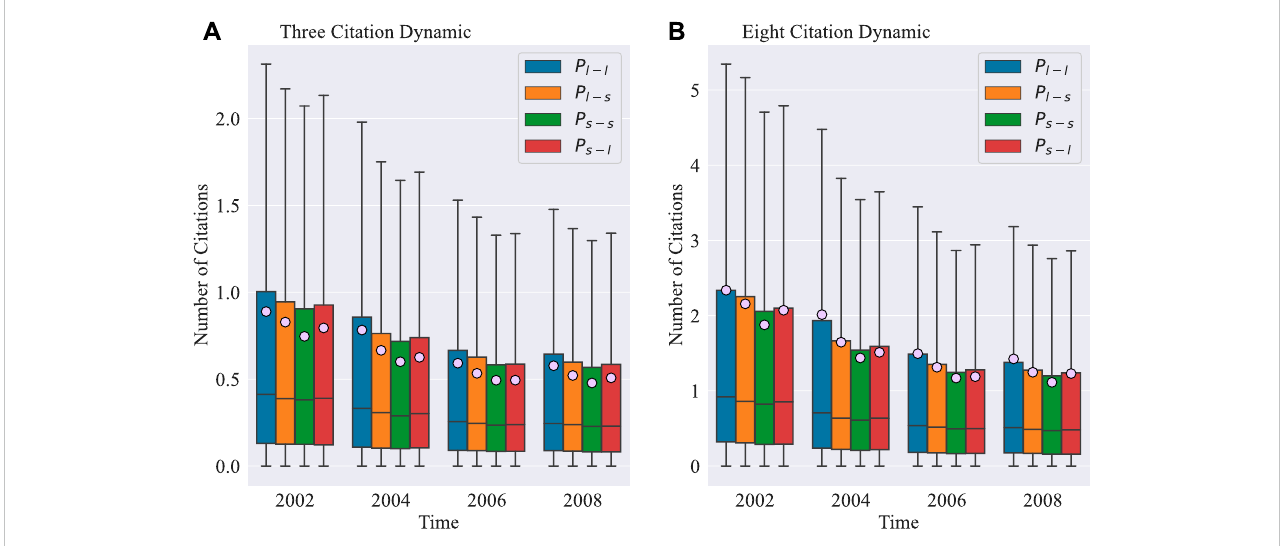
FIGURE 3 Theevolutionofcitationsofpaperswithindifferentinterdisciplinary types.Wecomparethenumberofcitationswiththree (A) andeight (B) yearscitation period, and other elements are consistent with Figure 2.